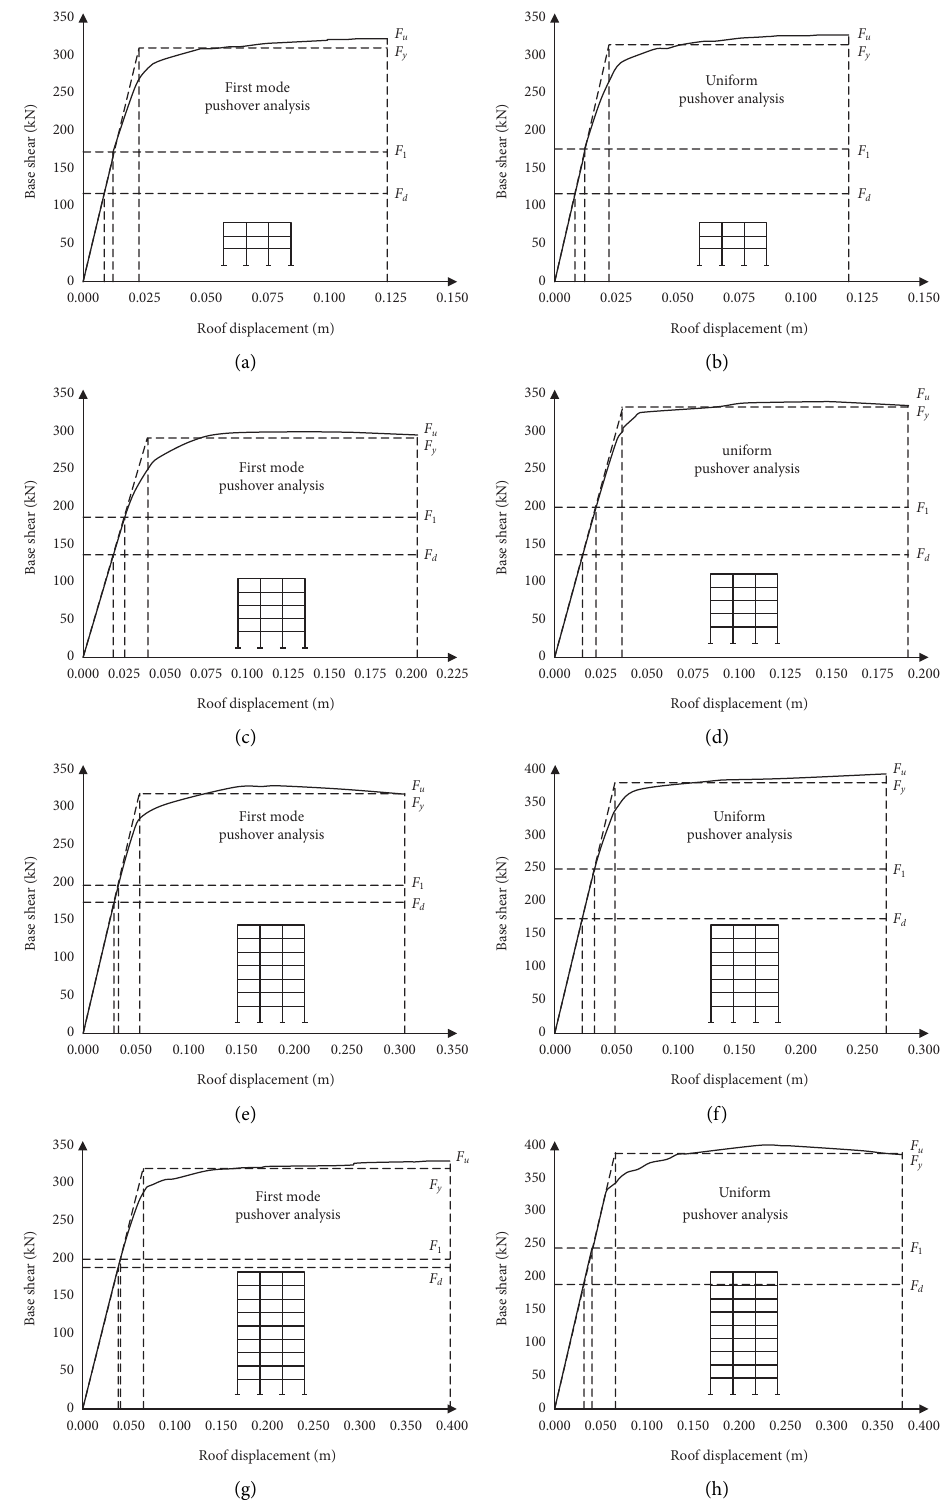
Figure 5: Base shear versus roof displacement. 3S3B, 5S3B, 7S3B, and 9S3B